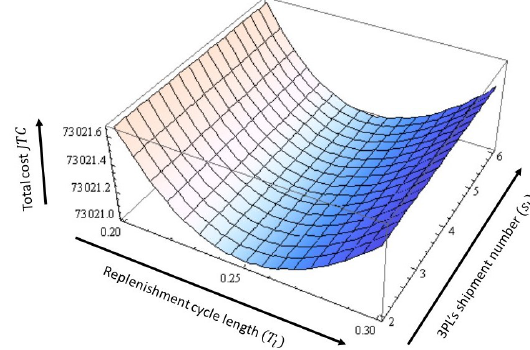
Figure 4. Total cost (JTC) for the CLSC versus 3PL’s shipment number ( s l ) and replenishment cycle length ( T l ) when s m and β are fixed, s l and T l are variable.